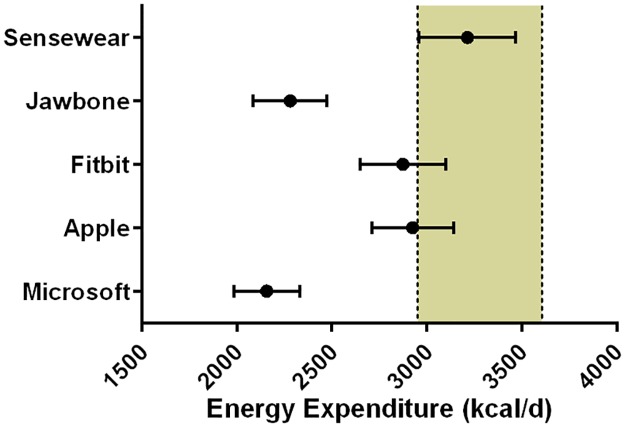
95% equivalence testing for daily energy expenditure.The shaded area bordered by dashed black lines is the proposed equivalence zone (±10% of the criterion mean). The mean of the daily energy expenditure estimates is shown for the devices, bordered by 90% confidence intervals.